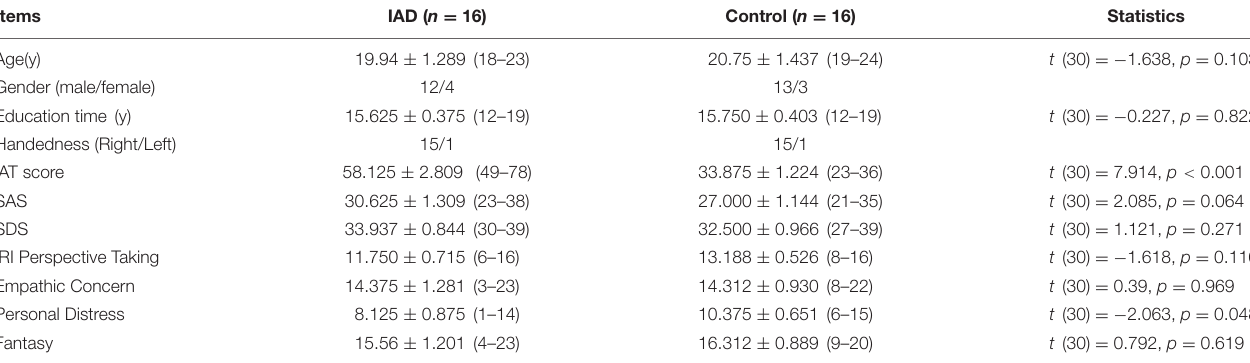
TABLE 1 | Participants demographics for IAD participants and healthy controls.